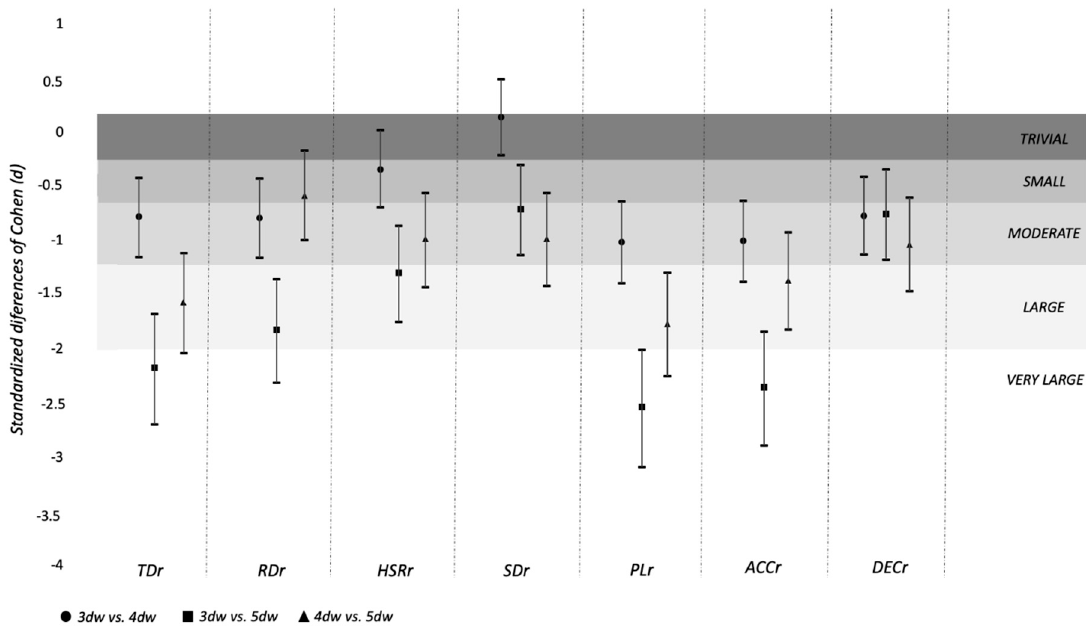
Figure 3. Standardized differences of the different external load ratios between types of week (overall data, not split by playing positions).